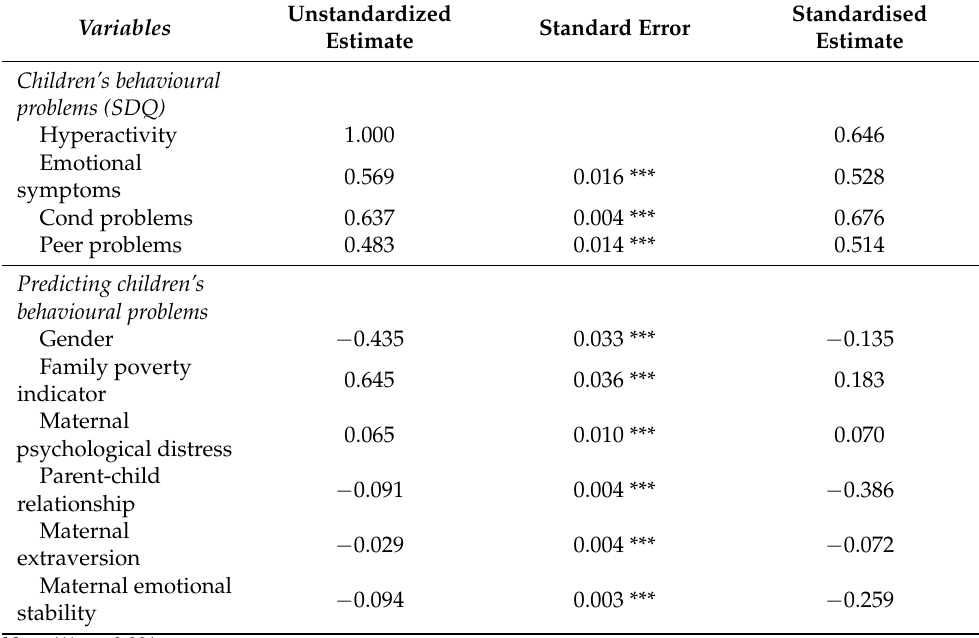
Table 2. Unstandardized estimate, standard error and standardised estimate of the latent and observable variables of SEM that predict children’s behavioural